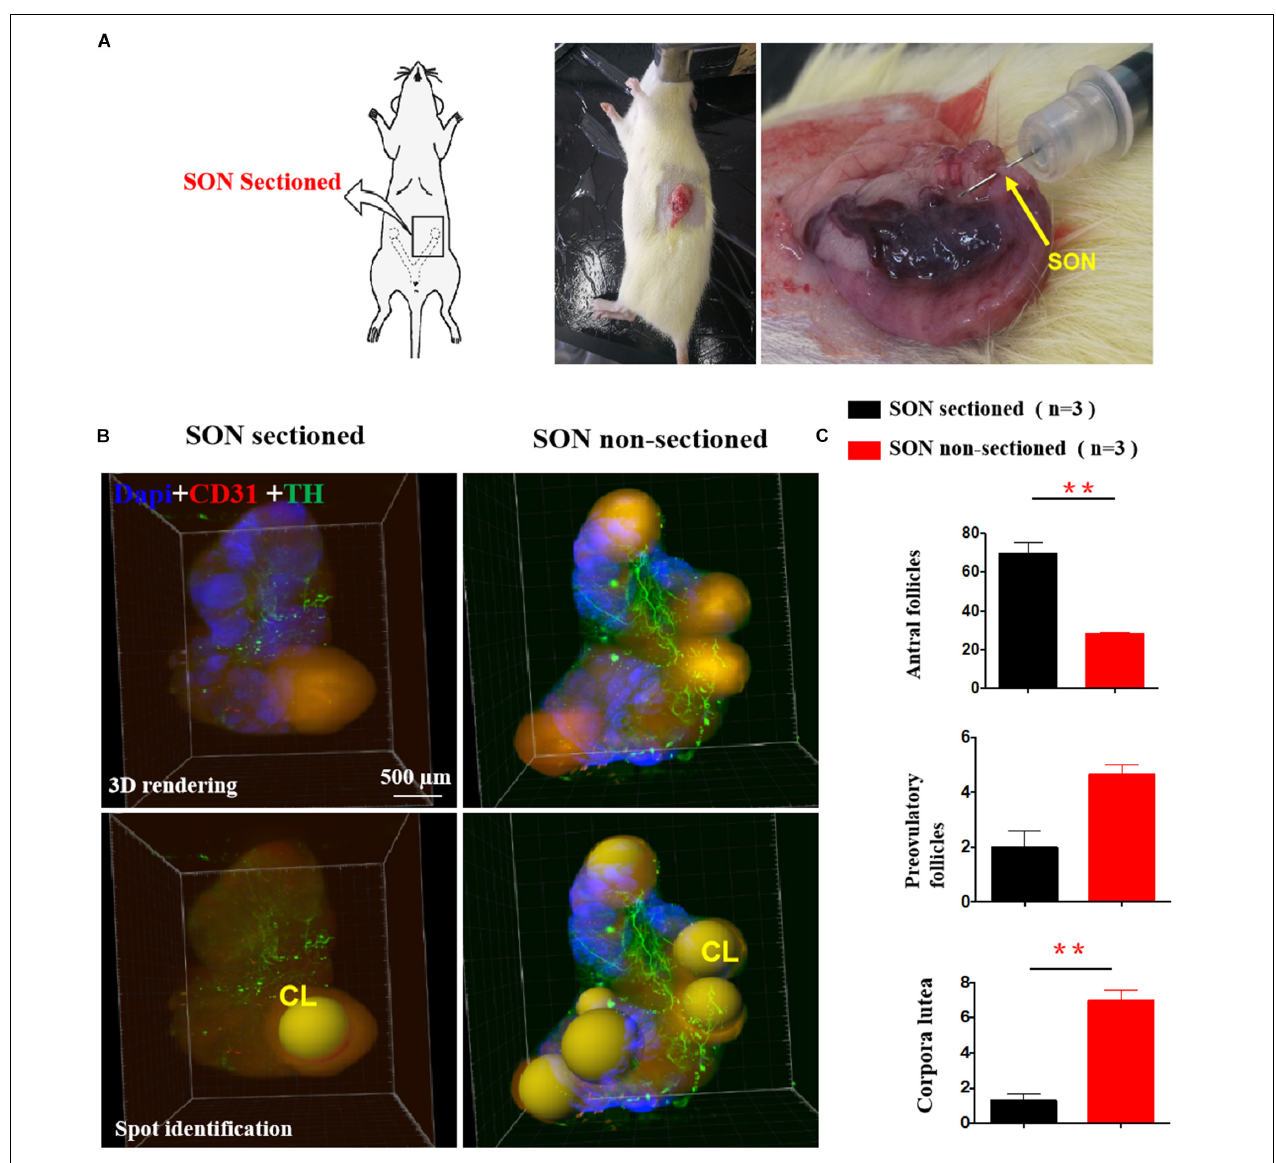
FIGURE 6 | The effect of unilateral SON neurectomy on EA-induced changes in ovarian innervation and vasculature in PCOS-like rats. (A) Unilateral SON neurectomy in PCOS + EA rats.Arrow indicated the SON. (B) Mature follicles and corpora lutea of the ovaried without SON were decreased compared with those of ovaries with SON. (C) Quantitative and statistics analysis of antral, preovulatory follicles, and corpora lutea. ** p < 0.01 vs. SON sectioned